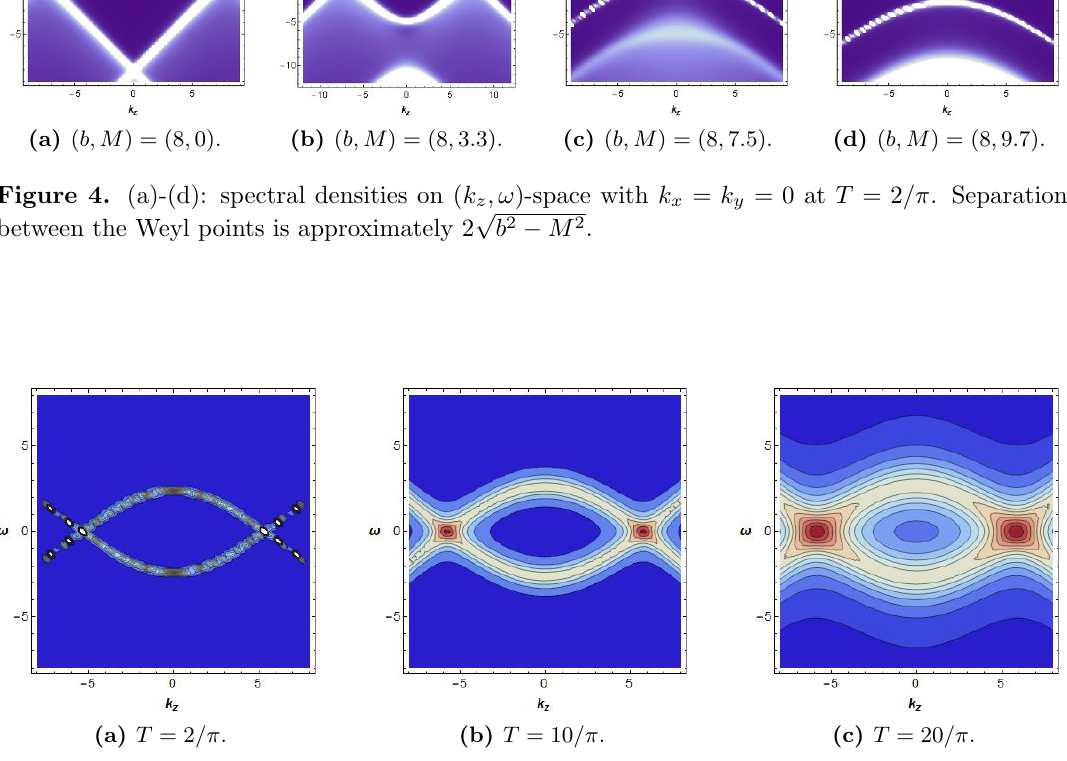
Figure 5. (a)-(c): as temperature increases, spectrum broadens. Color code denotes the spectral height. We used k x = k y = 0 and ( b; M ) = (8 ; 3 : 3).